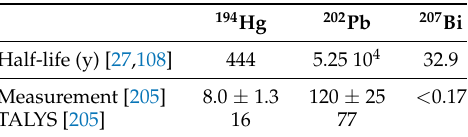
Table 7. Rates of production of long-lived radioisotopes induced in natural lead at sea level. Measurements and calculations from Ref. [205] are presented (see text). All numbers are expressed in